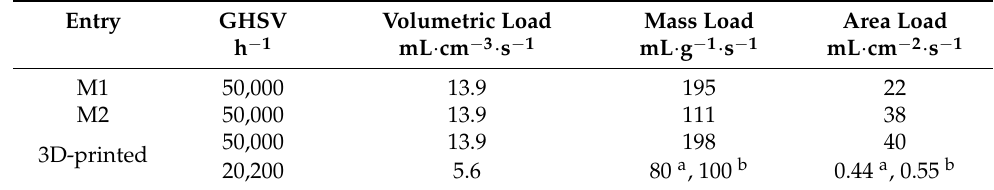
Table 2. Characteristics of the three monolith